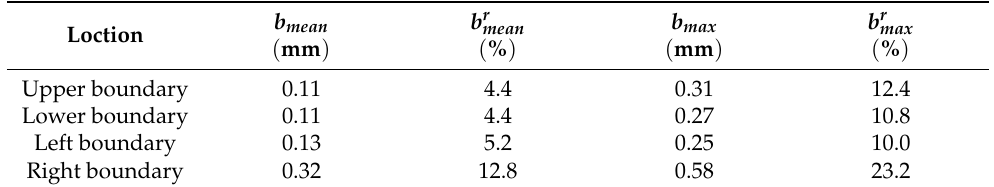
Table 1. Error statistics of the upper, lower, left, and right boundaries of the reconstructed weld pool surface.